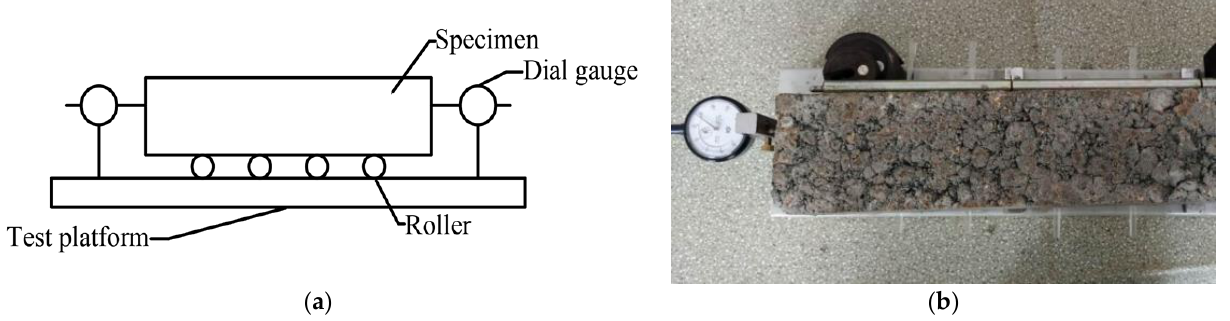
Figure 4. Compressive-resilience modulus test: ( a ) test setup; ( b ) test specimen.